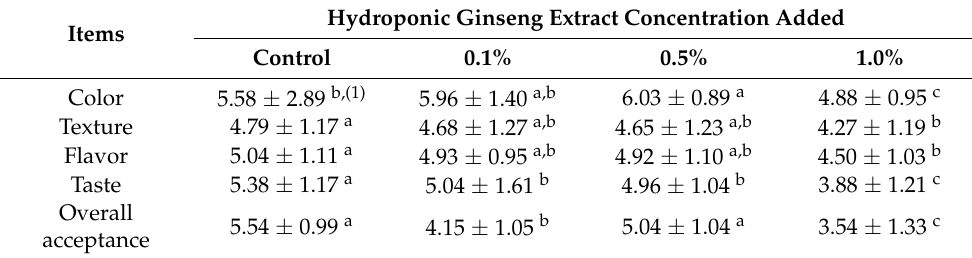
Table 2. Sensory evaluation of yogurt supplemented with various ginseng